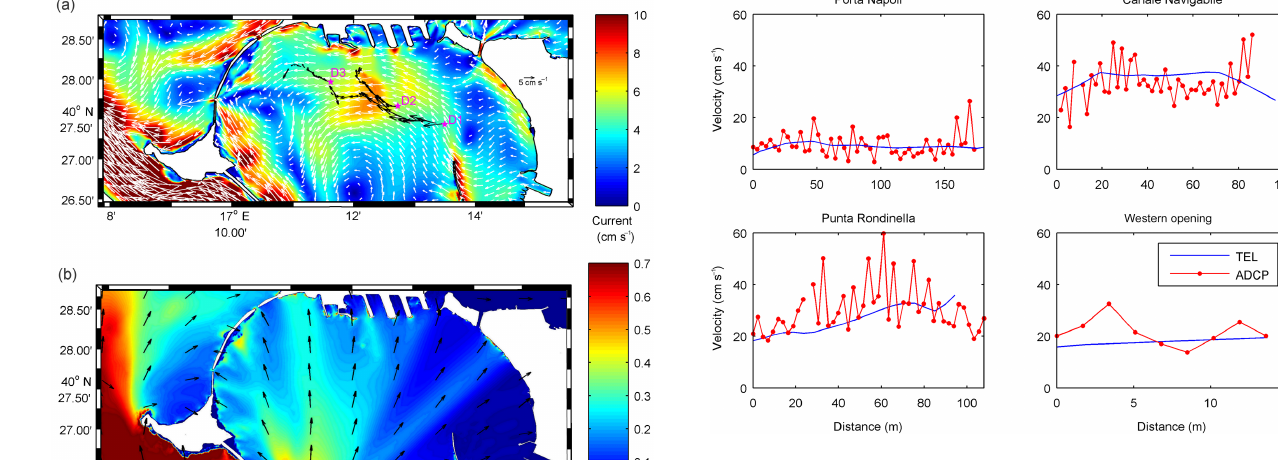
Figure 10. Depth-averaged velocity along four opening sections in Mar Grande: TEL3D + TOM results (blue line) and ADCP measure- ments (red line and circle